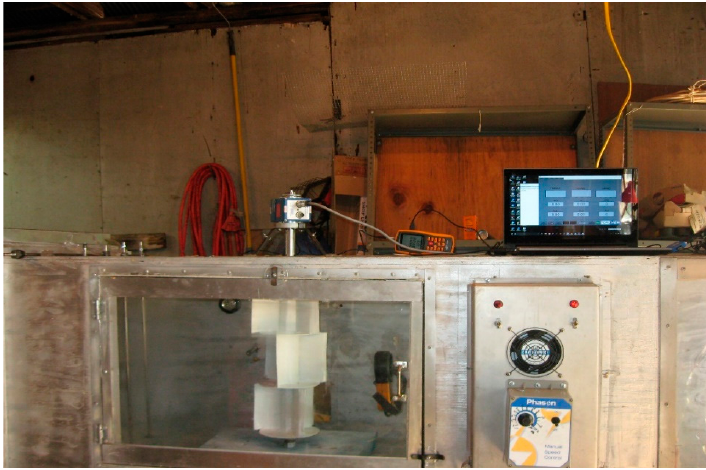
Figure 3. Setup for measuring AVAWT performance parameters. Appl. Sci. 2020 , 10 , x